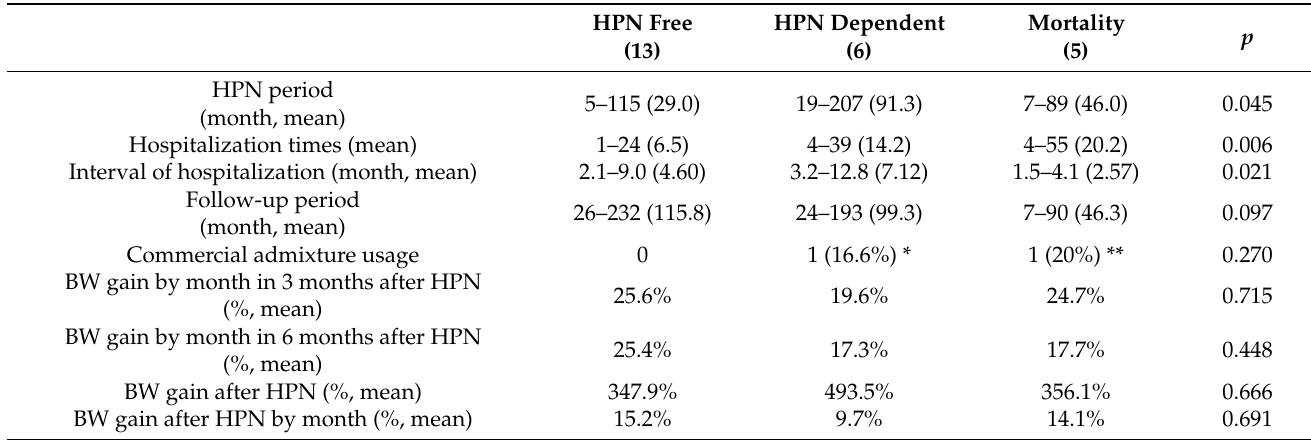
Table 2. Clinical outcomes and formula of pediatric HPN